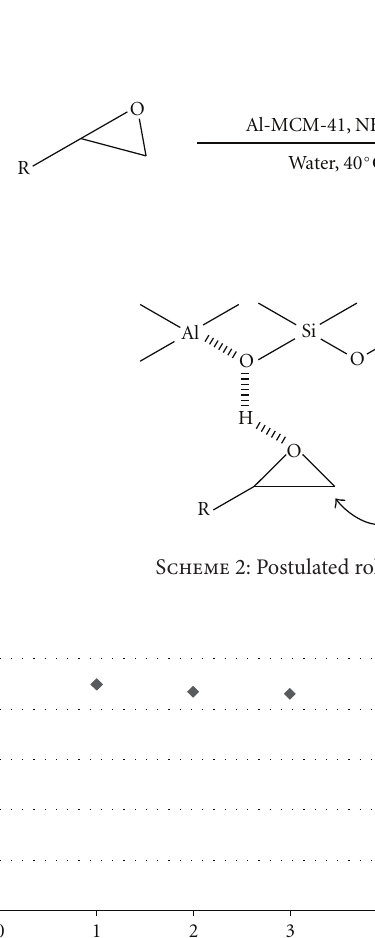
F 2: Synthesis of 3-phenoxy-2-hydroxypropyl thiocyanate with recovered